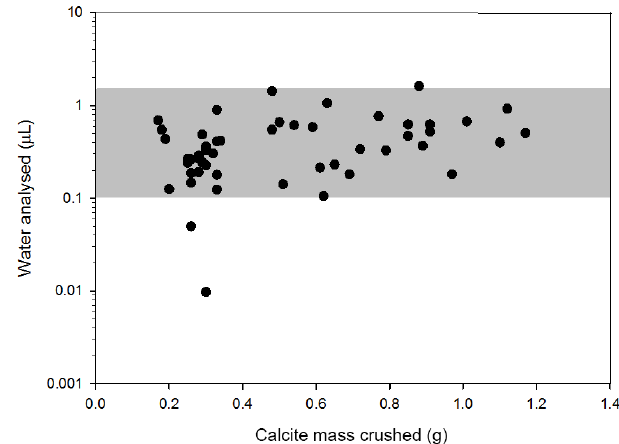
Figure 3. Variability of water content (µL) per unit mass of speleothem (g) in SC-06-01 fluid inclusion samples. Grey area shows working range of instrument.